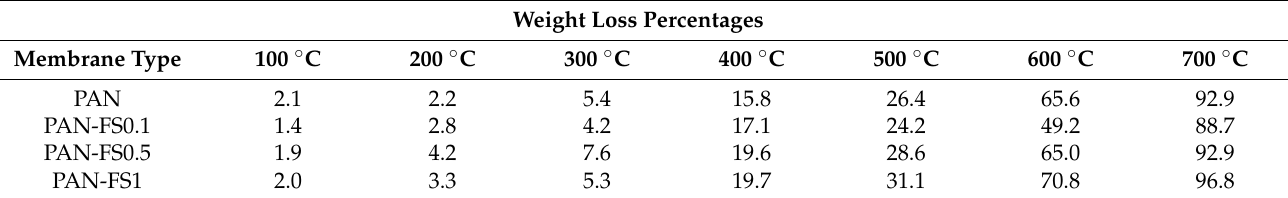
Table 2. Weight loss percentages of prepared membranes for various